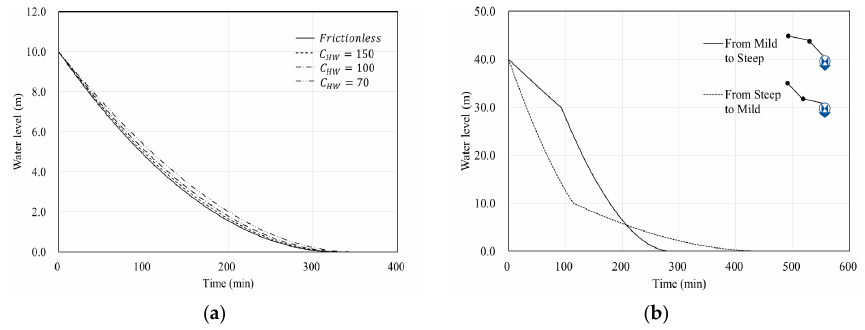
Figure 5. Drainage time: ( a ) friction effect on a single pipe; ( b ) serially connected pipes with the same properties.